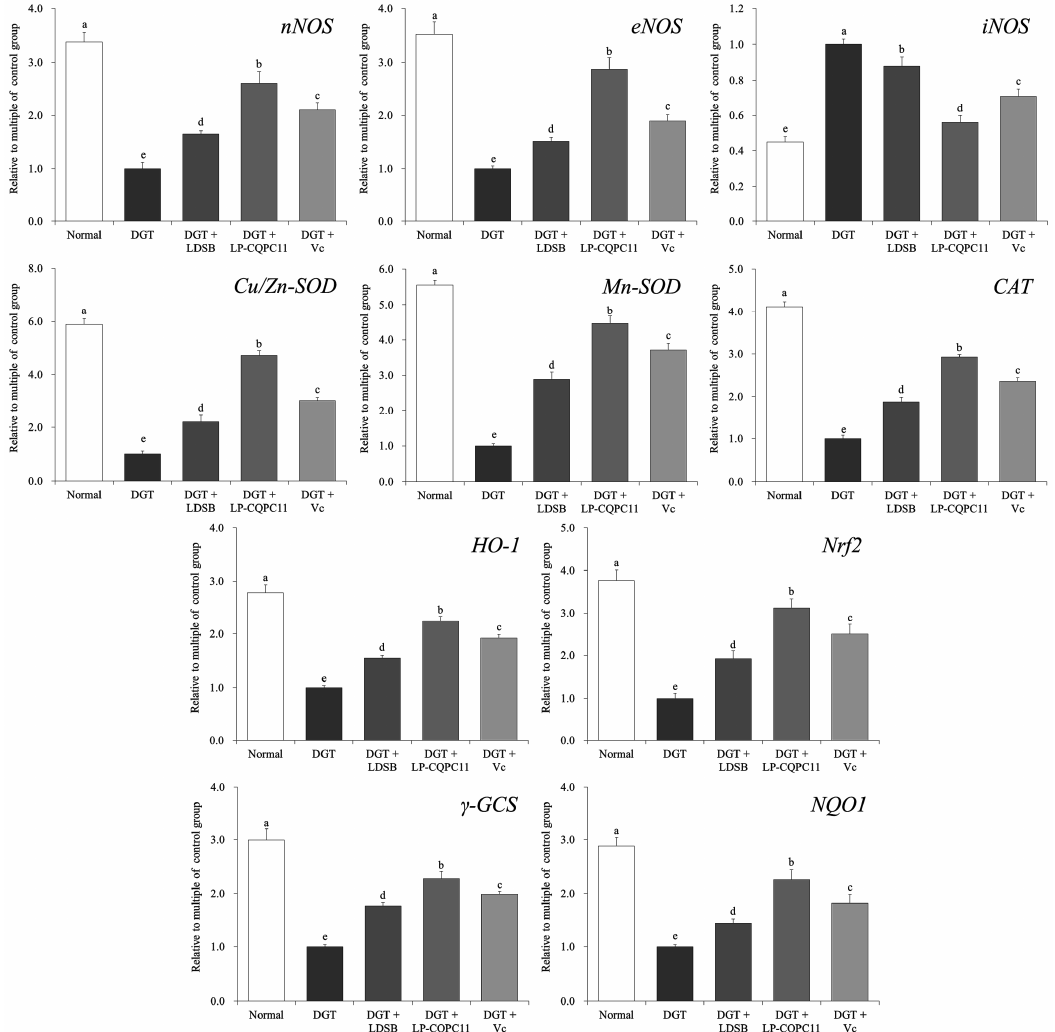
Figure 5. The mRNA expression in spleen of mice. a–e The different letters mean that there are significant differences ( p < 0.05) between every two groups according to Duncan’s multiple range test. DGT: mice treated with D -galactose; DGT + LDSB: mice treated with D -galactose and Lactobacillus delbruechii subsp . bulgaricus (1.0 × 10 9 CFU/kg); DGT + LP-CQPC11: mice treated with D -galactose and Lactobacillus plantarum CQPC11 (1.0 × 10 9 CFU/kg); DGT + Vc: mice treated with D -galactose and vitamin C (200 mg/kg).